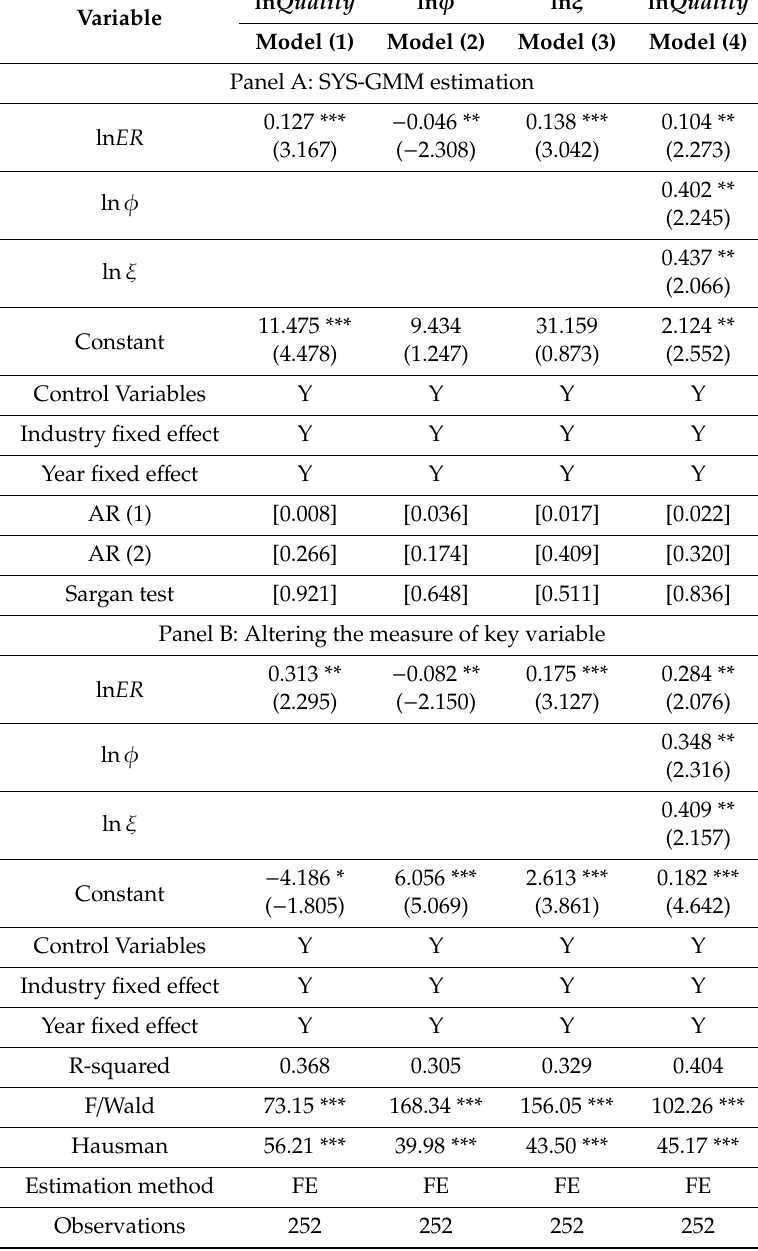
Table 8. Results of the robustness